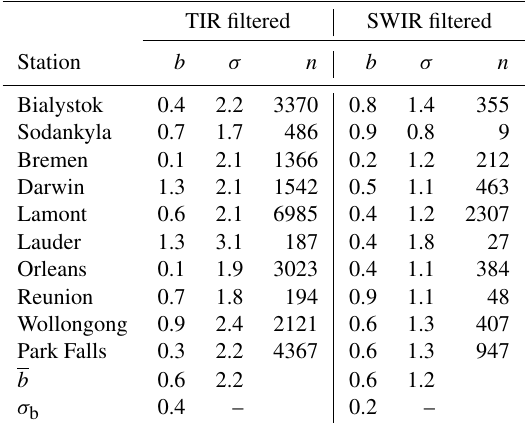
Table 1. Total methane column retrieval results after applying the bias-correction scheme for scenes over land during daytime. The first three columns pertain to the cloud filter, based on fit parameters of GOSAT-TIR retrievals, whereas the last three columns refer to the filtering of exploiting spectral features in GOSAT SWIR and NIR spectra. The average remaining bias is given for each TCCON station used in the current study, along with the 1 σ spread and the number of measurements passing the particular filter. The last two rows show the values for the whole ensemble. TIR filtered SWIR